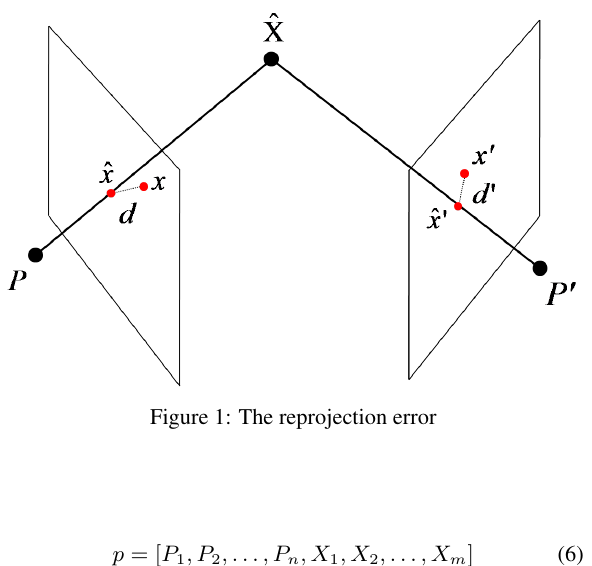
Algorithm 1 Iterative Closest Point (ICP)